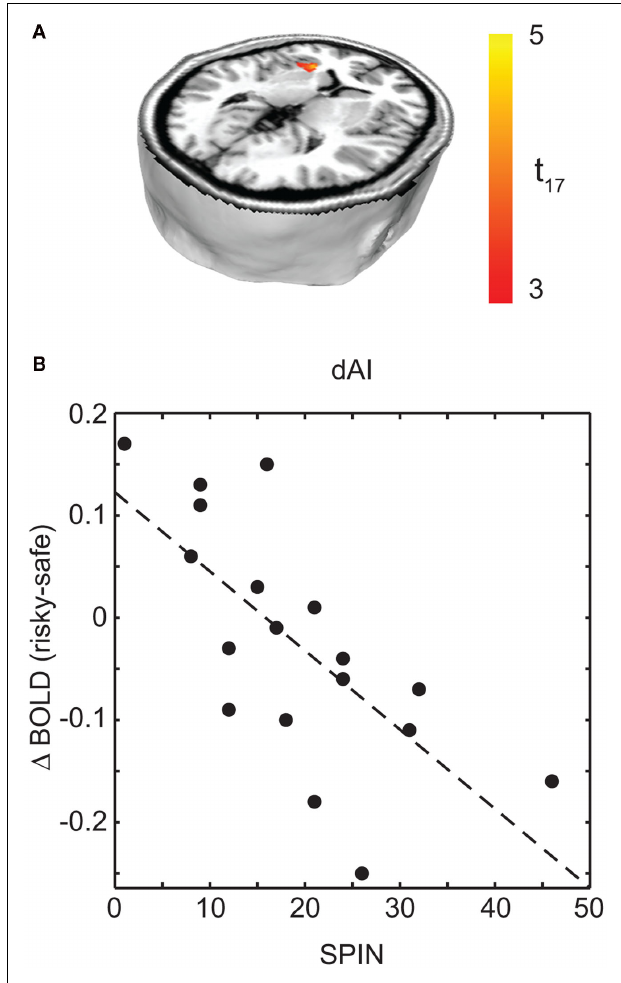
FIGURE 4 | Regions associated with social anxiety were identified as those that show a difference based on choice (risky–safe) as a function of SPIN score. (A) This analysis identified a single region of interest in left dAI ( p < 0.05, corrected). (B) Within this region of dAI, SPIN scores were negatively correlated with BOLD contrasts for risky–safe choices. Low SPIN individuals had higher activation in the dAI for risky versus safe choices, while the opposite was true in high social phobic individuals. See Table 3 .